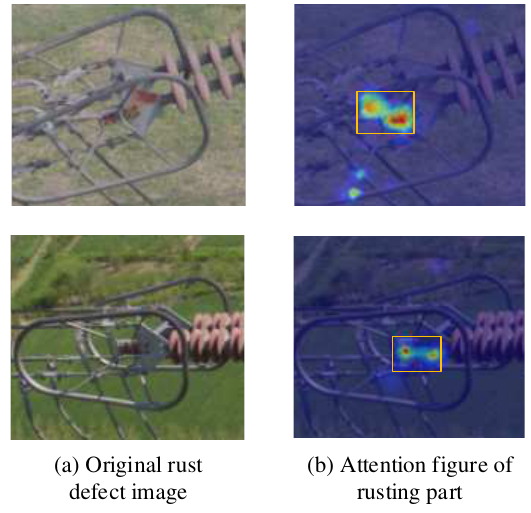
Figure 20. Visualization results of local attention map in rust area.